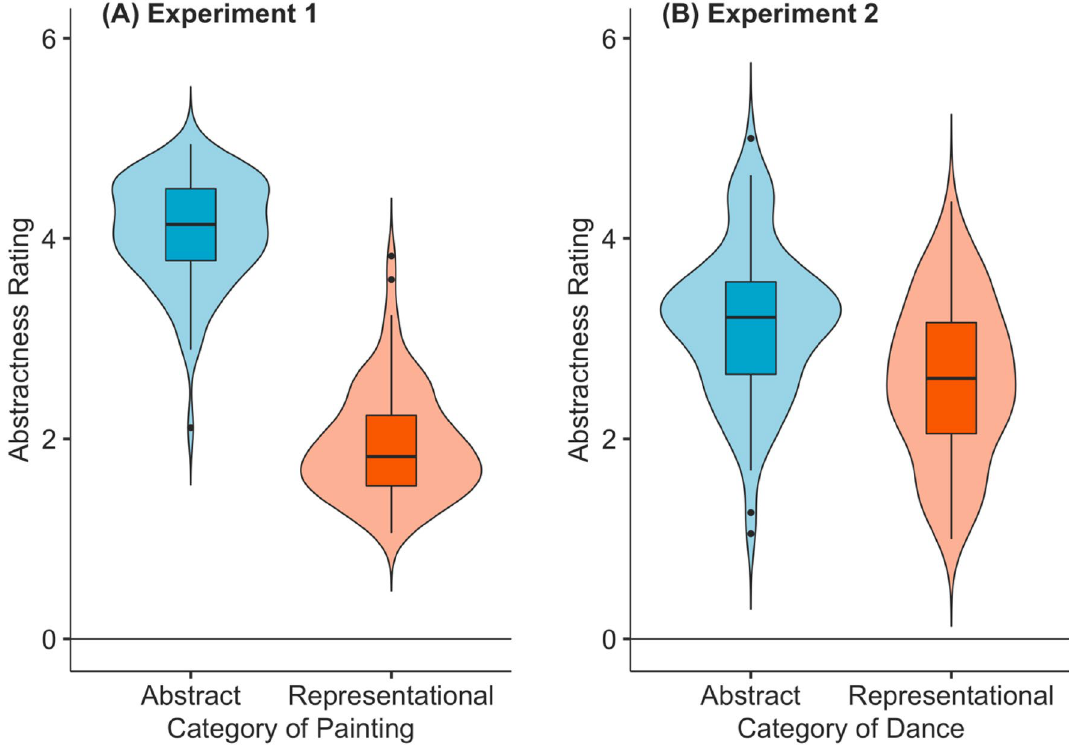
Figure 3. Abstractness ratings (on a 5-point likert scale where 1 = not at all abstract, and 5 = extremely abstract) for abstract and representational paintings (A; Experiment 1) and abstract and representational dance (B; Experiment